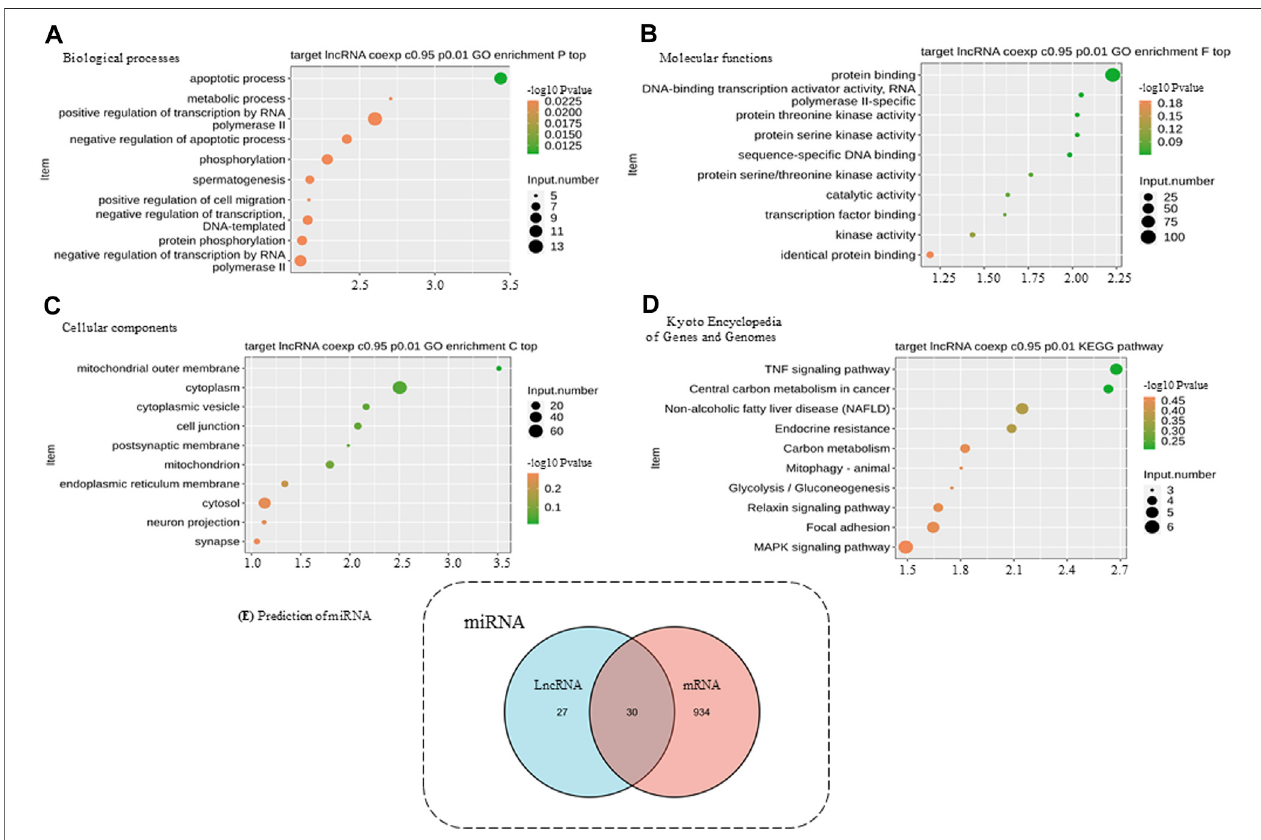
FIGURE 3 | Functional enrichment analysis of differentially expressed genes and miRNA prediction. (A) BP, biological processes. (B) MF, molecular functions. (C) CC, cellular components. (D) KEGG, Kyoto Encyclopedia of Genes and Genomes. (E) DIANA databases were used to predict target miRNA. The numbers ofpredicted targetmiRNAsarepresentedinaVenndiagram. ThepredictedresultsoflncRNAs andmRNAswereintegrated, andonly theintersectionswereselectedtoincrease the speci fi